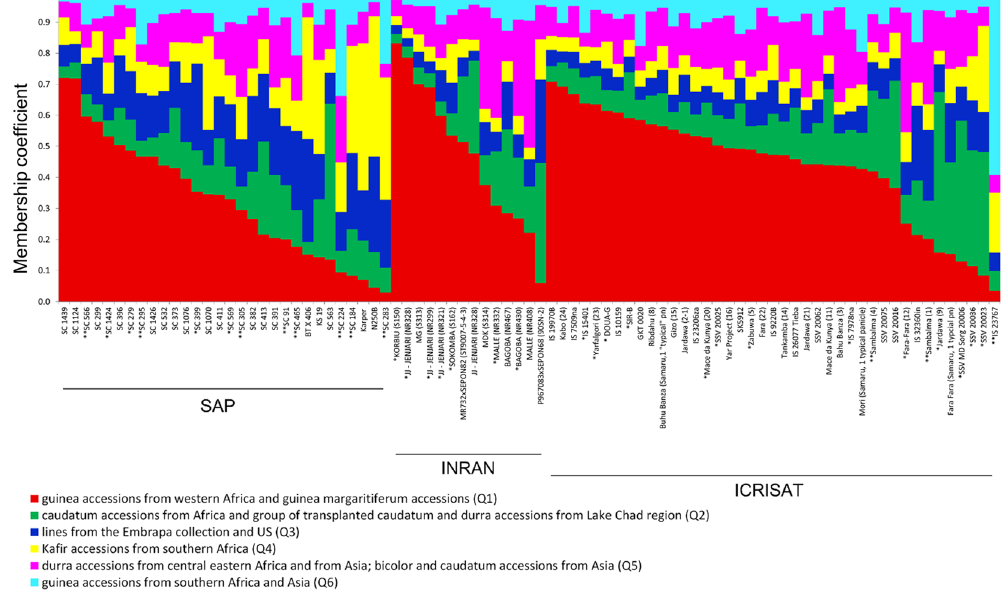
Figure 5. Subpopulation assignments for sorghum accessions with favorable Alt SB alleles. The genotypic data for accessions with favorable Alt SB alleles was integrated into the Caniato et al . 26 dataset (Fig. S3 and Table S6 in 26 ) by genotyping with the same set of SSR markers used in that study. The subpopulations are: Q1, guinea accessions from western Africa and guinea margaritiferum accessions; Q2, caudatum accessions from Africa and group of transplanted caudatum and durra accessions from Lake Chad region; Q3, lines from the Embrapa collection and US; Q4, kafir accessions from southern Africa; Q5, durra accessions from central eastern Africa and from Asia; bicolor and caudatum accessions from Asia; and Q6, guinea accessions from southern Africa and Asia. Double and single asterisks depict Al tolerant and intermediate individuals,